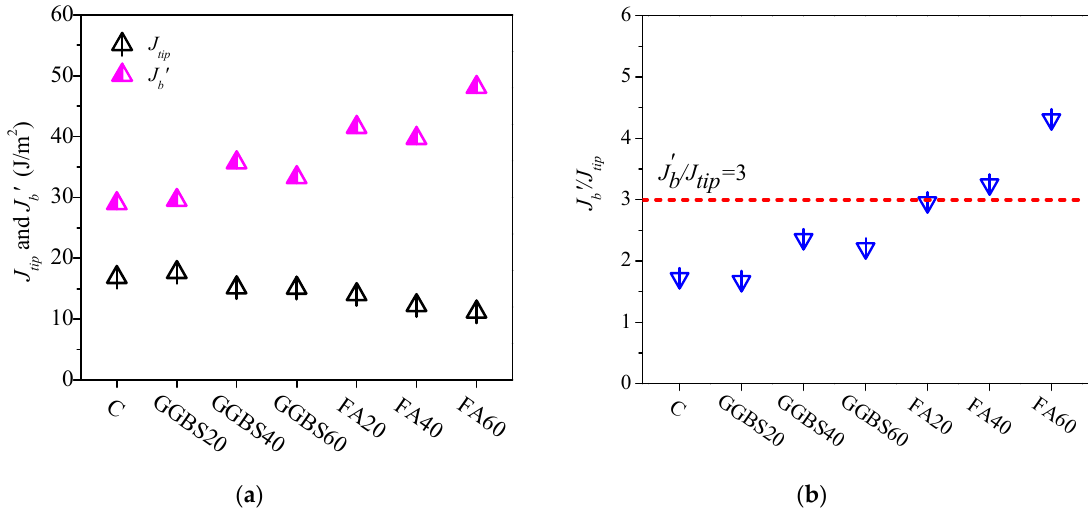
Figure 17. ( a ) Crack tip toughness J tip and complementary energy J b ’ of all mixtures; ( b ) Toughness ratio as a function of GGBS/FA replace ratio for all mixtures.